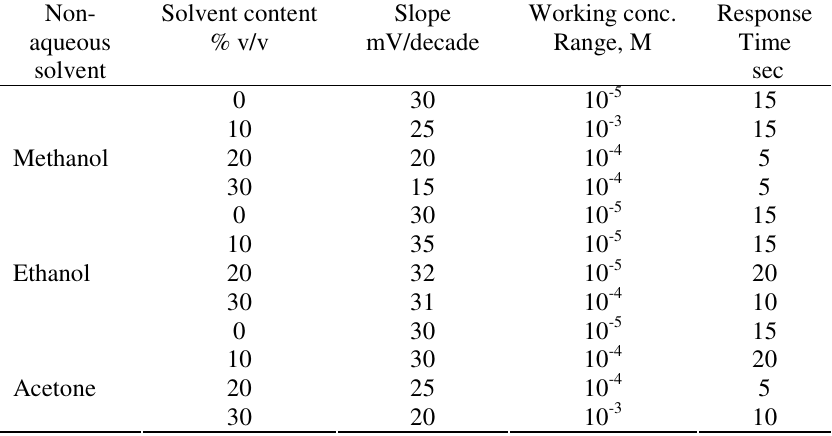
Table 5. Effect of non-aqueous